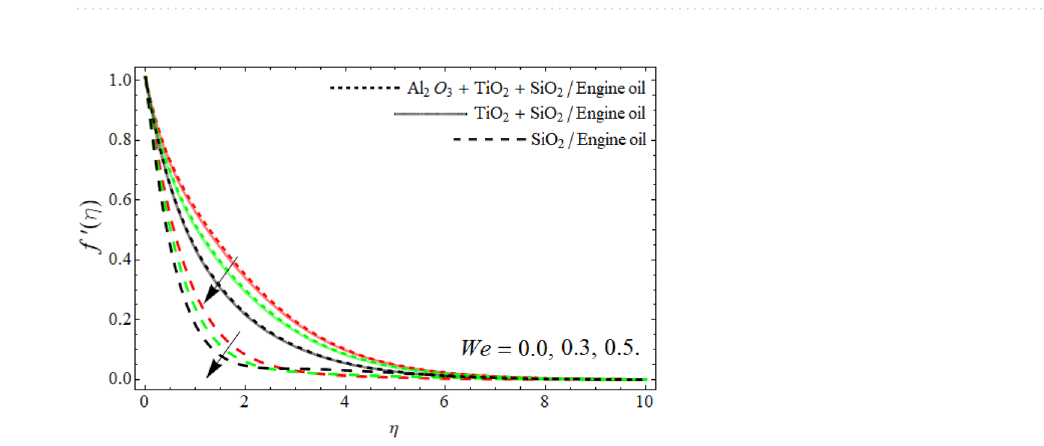
Figure 3. Velocity f ′ (η) field versus ternary nanoparticles ϕ .